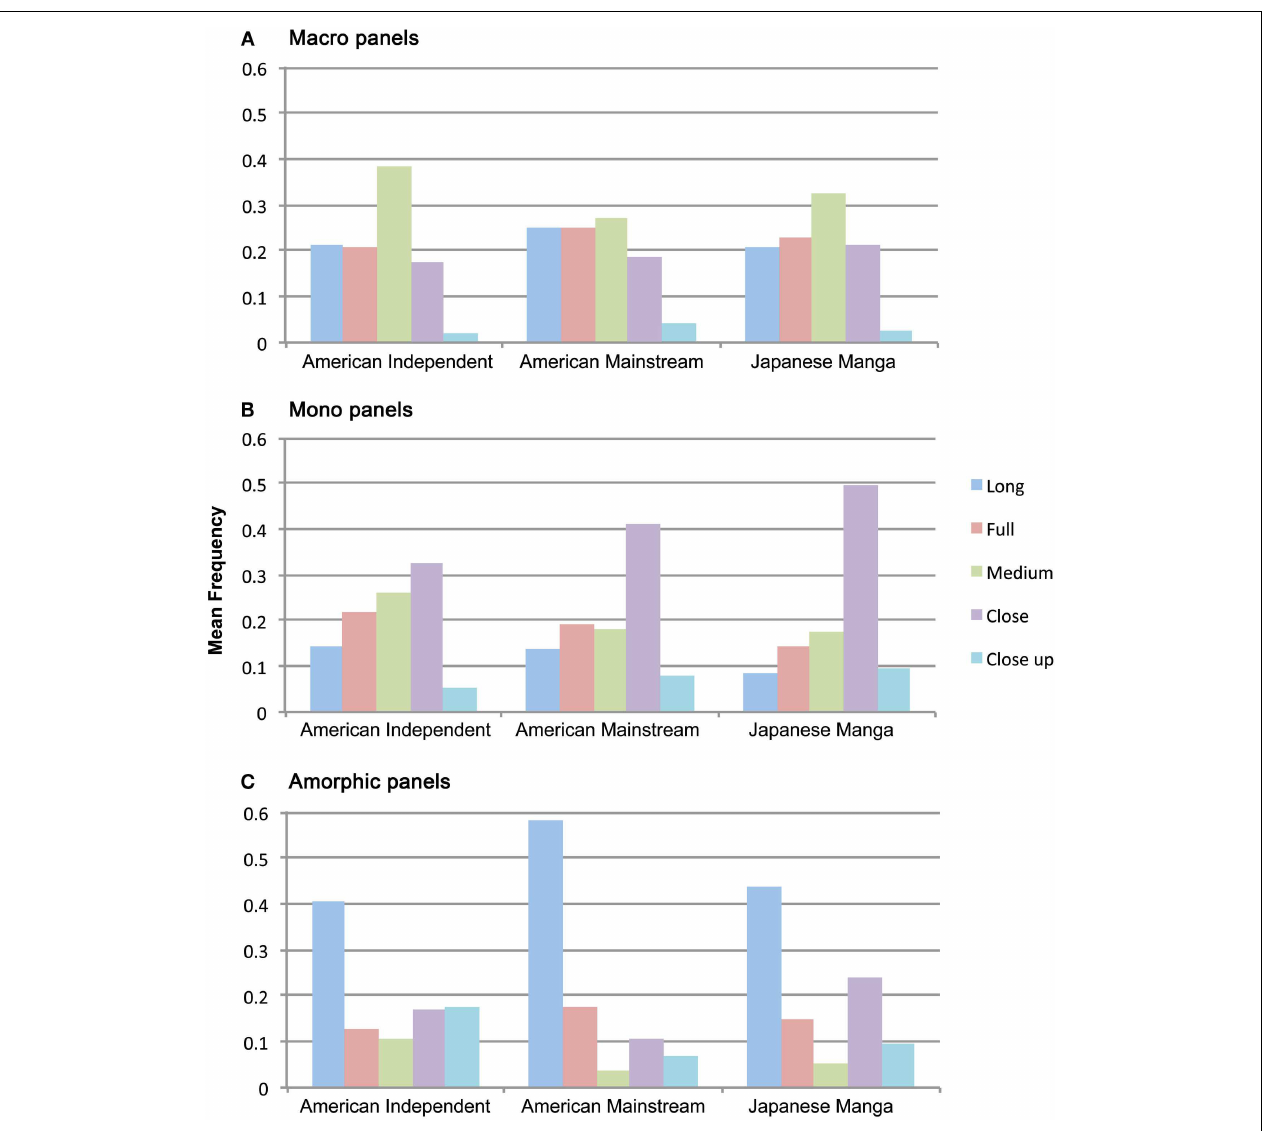
FIGURE 6 | Proportion of attentional categories—(A) Macros, (B) Monos, (C)Amorphic panels—represented by each of the filmic shot types in American Independent and Mainstream comics and Japanese